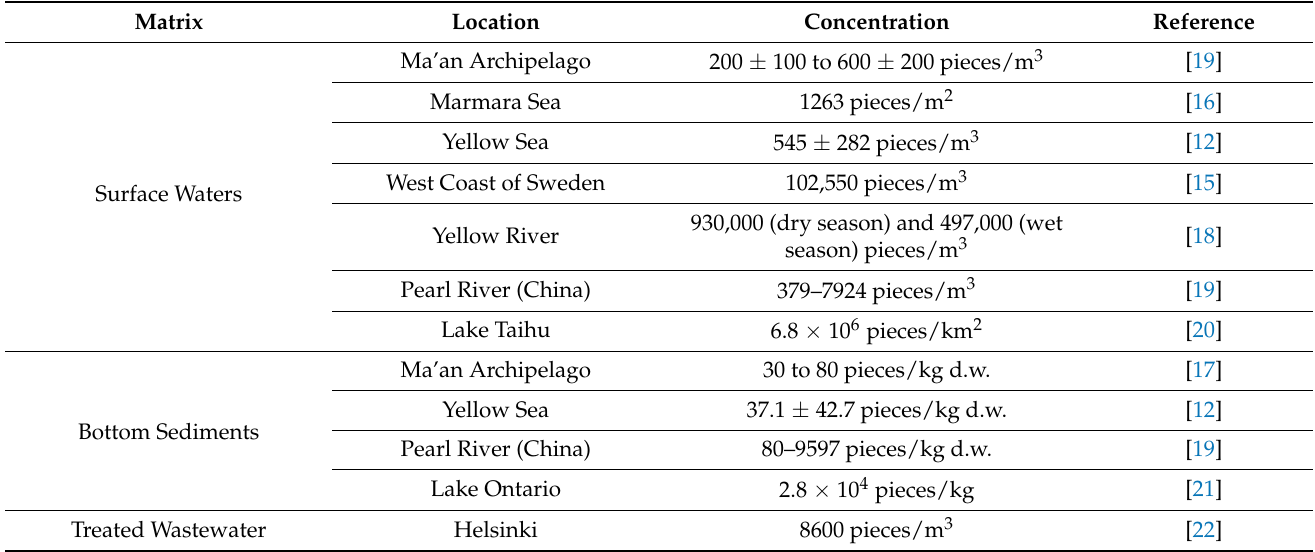
Table 1. Summary of selected references with data on the occurrence and fate of MPs in the various components of the